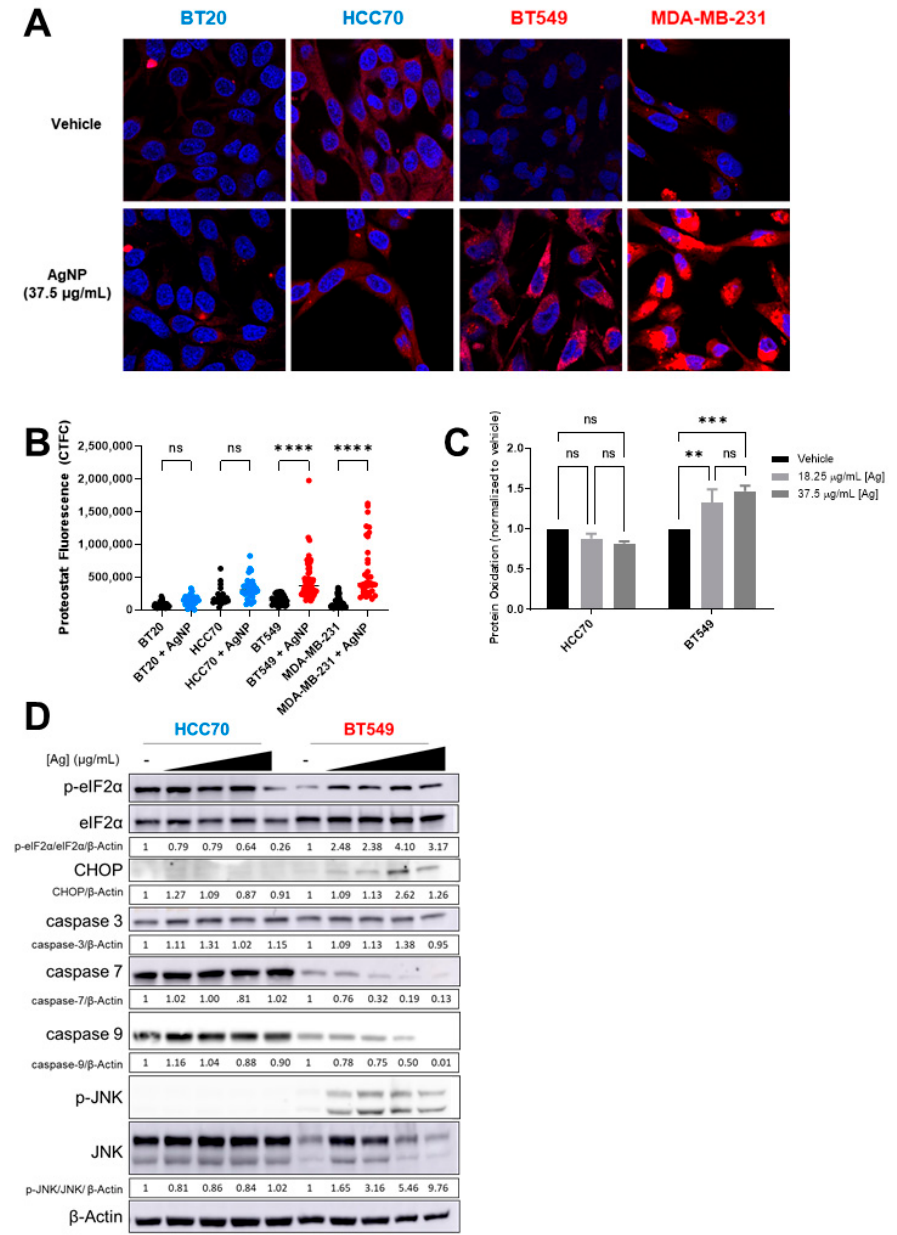
Figure 5. AgNPs induce protein aggregation and protein oxidation and activate proteotoxic stress responses in CLBC but not BLBC. ( A , B ) To assess protein aggregation, BLBC (blue) or CLBC cells (red) were treated with AgNPs for 24 h, stained with Proteostat aggresome dye, and fluorescence was measured using confocal microscopy. ( A ) Microscopy results shown are representative images from three independent experiments with at least three random fields assessed per sample. ( B ) Fluorescence intensity was quantified in at least 10 cells per field and statistical analysis was performed by one-way ANOVA followed by post hoc Tukey test. Significant differences are indicated (**** p < 0.0001). ( C ) To assess protein oxidation, cells were treated with AgNPs for 24 h, stained with DCP-Net2C, and fluorescence assessed by flow cytometry. Data were obtained from three independent experiments. Statistical analysis was performed by two-way ANOVA followed by post hoc Tukey test. Significant differences are indicated (** p < 0.01; *** p < 0.001). ( D ) To assess ISR signaling, cells were treated with 0, 18.25, 37.5, or 75 μ g/mL AgNPs for 24 h and protein expression was evaluated by Western blot. Densitometry was performed and the ratio of peIF2 α /eIF2 α or each individual protein to β -actin was calculated as indicated. The results are representative duplicate independent experiments.